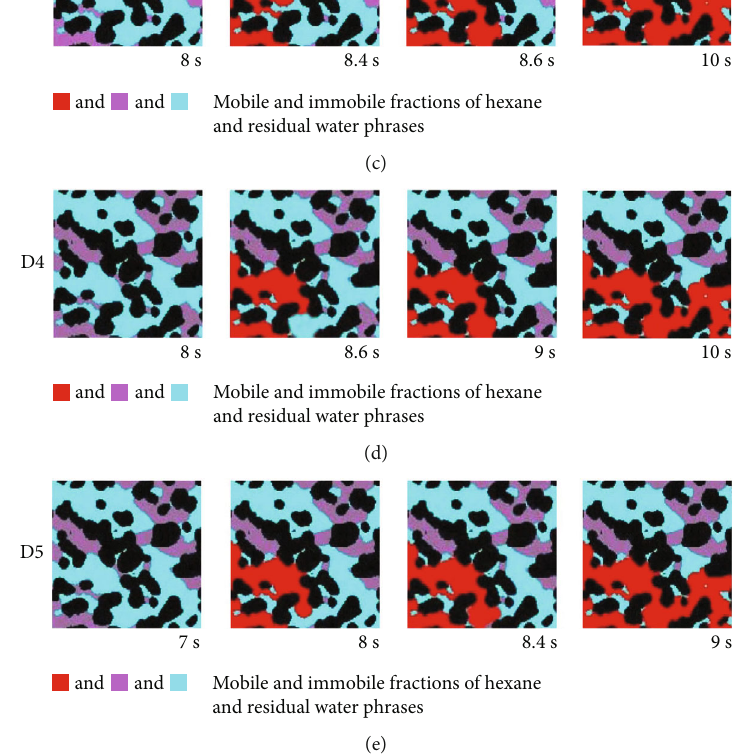
Figure 8: Sequential magni fi ed images of fl uid distribution in a selected segment of the micromodel during drainage